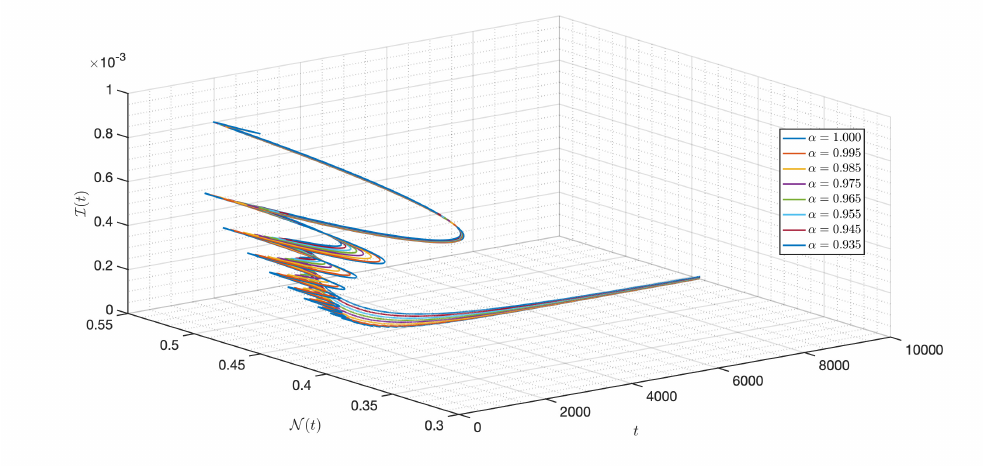
Figure 30. Dynamic of the model (3) for different parameters in Case III .